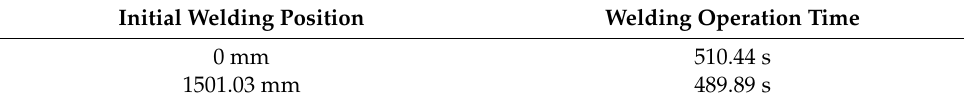
Figure 12. Angle of each joint of the robot. Figure 11. Base joint angle change process. Table 4. Experimental results of different initial welding positions of the robot.